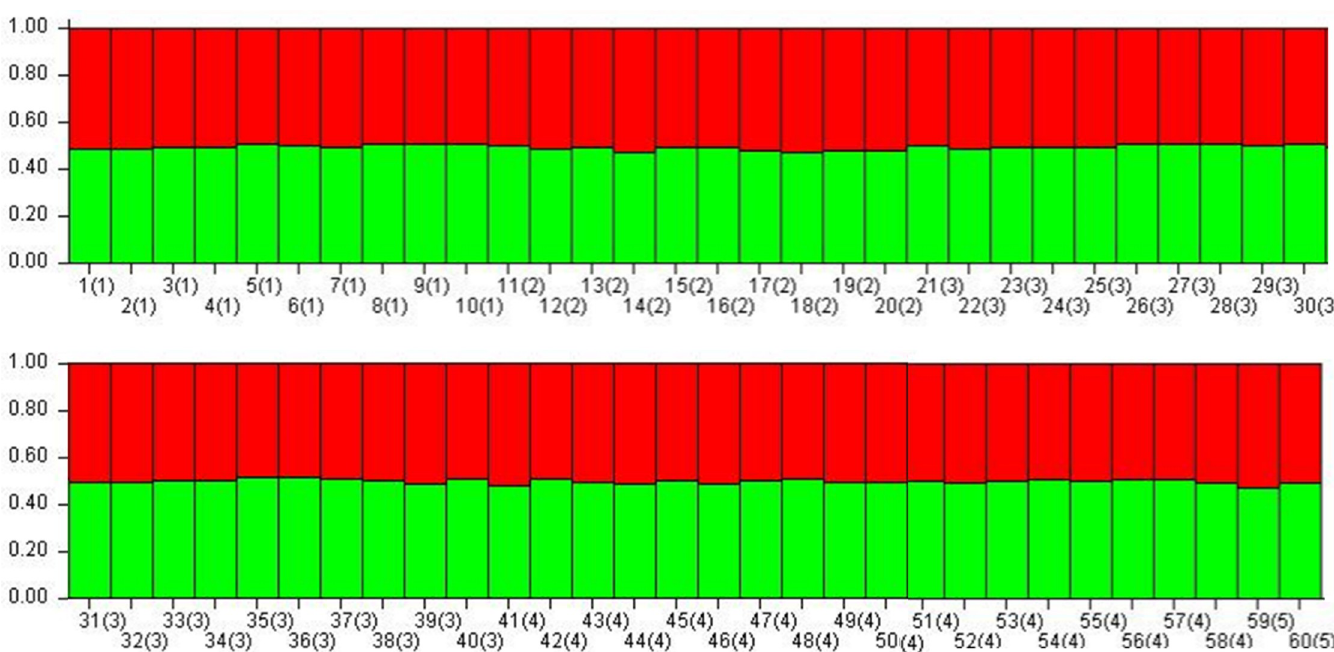
Fig 2. Population structure of Himalayan black bears from ACA, Nepal without prior sampling information. Vertical bar represented individual bears and color represented membership coefficient (q) of each individual which was less than 0.7 when K = 2; (1) = Jomsom, (2) = Ghandruk, (3) = Lwang, (4) = Sikes, (5) = Manang management units, and no 1–60 represents the individual identified from microsatellite analysis; Similar patterns were observed with prior information of location model. https://doi.org/10.1371/journal.pone.0207662.g002 posterior probability (q � 0.7) to any of the two clusters at K = 2 (Fig 2). Individuals from the ACA never formed a separate cluster even with increasing values of K. Results from STRUC- TURE and the log probability of all individuals revealed that the value of K is most likely 1 (S1 Fig). High variance between iterations and large standard deviations were observed with other estimated values of K (S6 Table). These results indicated that black bears from the ACA effec-